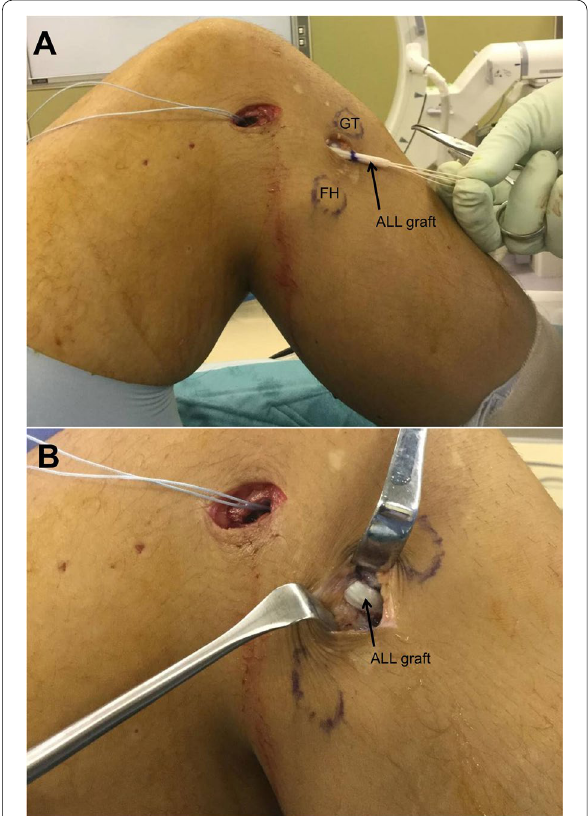
Fig. 1 Procedure for anterolateral ligament reconstruction. The view of lateral aspect of a right knee, placed supine during procedure for anterolateral ligament (ALL) reconstruction. (A) The femoral tunnel is created posterior and proximal to the lateral epicondyle with a minimal incision. The tibial tunnel is created with another incision from the mid-point between the fibular head and Gerdy’s tubercle. The ALL graft is passed under the iliotibial tract and superficial to the lateral collateral ligament aspect of the tibia, after fixation to the femoral tunnel. (B) The ALL graft is passed through the tibial tunnel. GT, Gerdy’s tubercle; FH, fibula